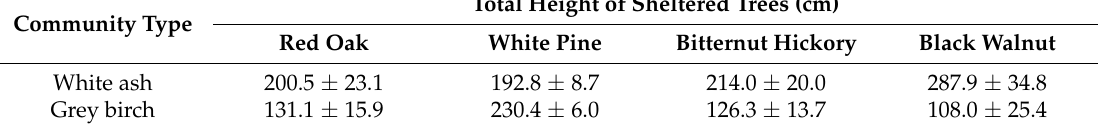
Table 3. Mean total height growth ( ± standard error) after 6 years for underplanted tree species protected with tree shelters in the two forest community types (N = 8 plots in the White ash community type and N = 17 plots in the Grey birch-balsam poplar-elm community type for red oak, white pine and bitternut hickory. For black walnut, N = 8 plots in the White ash community type and N = 15 plots in the Grey birch-balsam poplar-elm community type. All means are statistically different between community types at the α = 0.05 level following Student’s t -test.